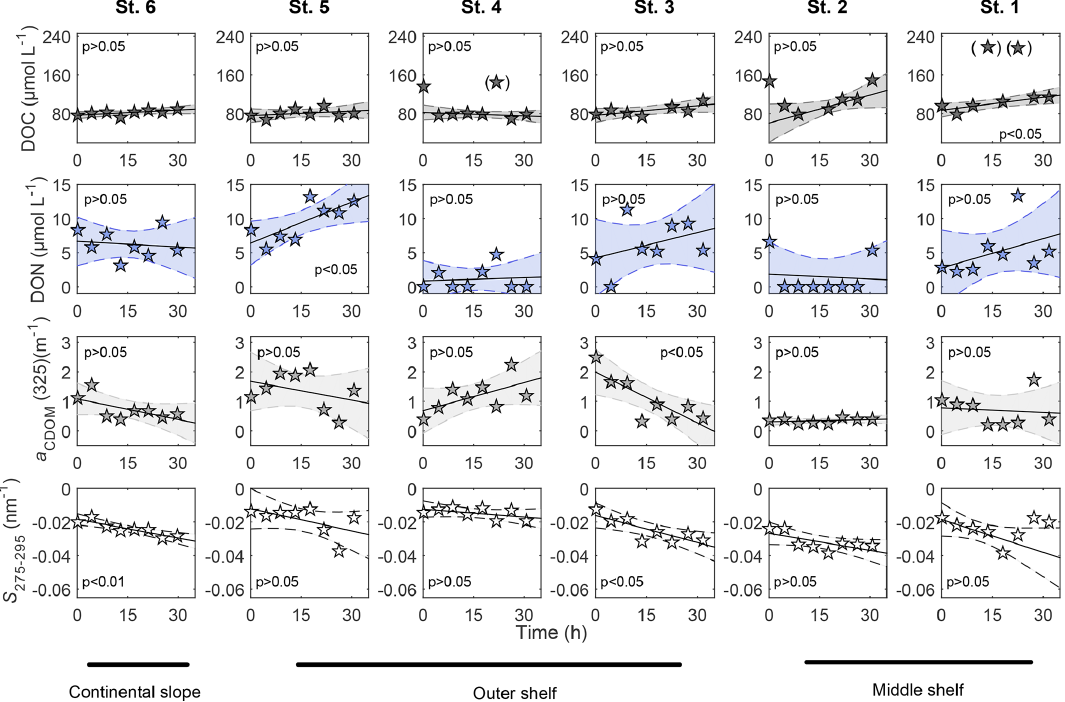
Figure 3. Distribution of DOC and CDOM parameters, a CDOM ( 325 ) and S 275 − 295 , measured in BIGO chambers over time. Polynomial fit (first order) was used for linear regression analyses: t 0 and data included in brackets were excluded from the analyses.